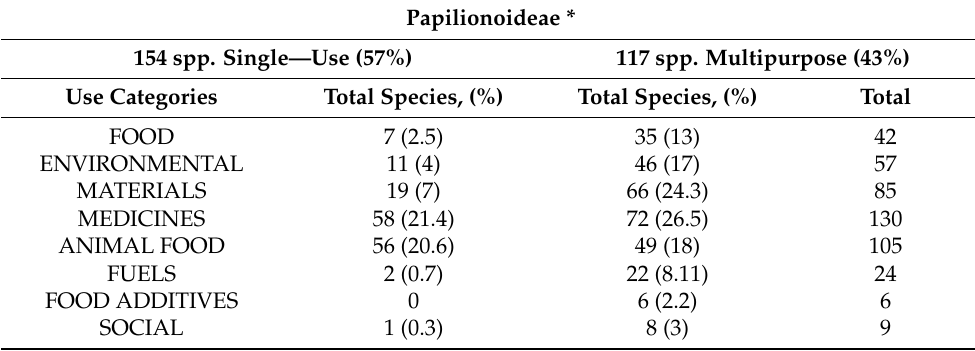
Table 4. Values of eight selected use categories of Papilionoideae, calculated percent of a total of 271 species. Categories values are based on Figure S3 (Supplementary Materials). * ca. 60% woody plants. Matrix correlation: r =